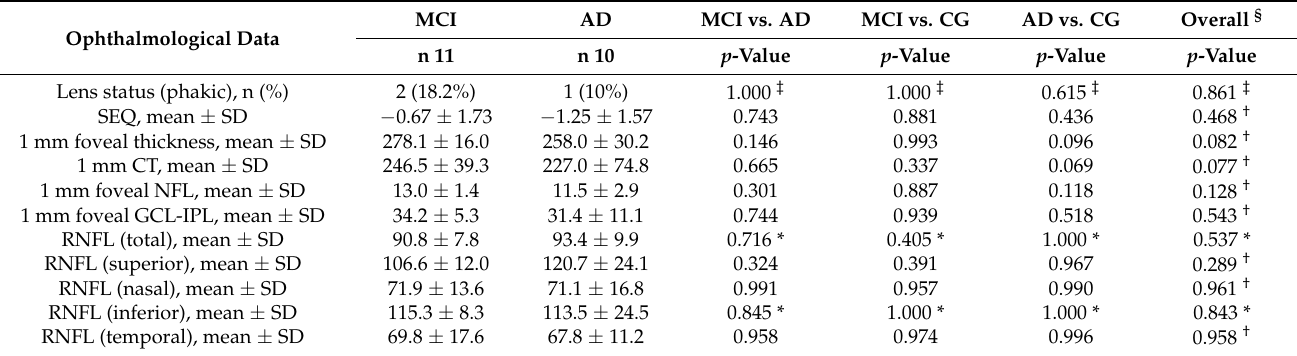
Table 4. Clinical and Optical coherence tomography (OCT) data stratified by mild cognitive impairment due to Alzheimer’s disease (MCI), Alzheimer’s disease (AD) patients, and control group (CG).